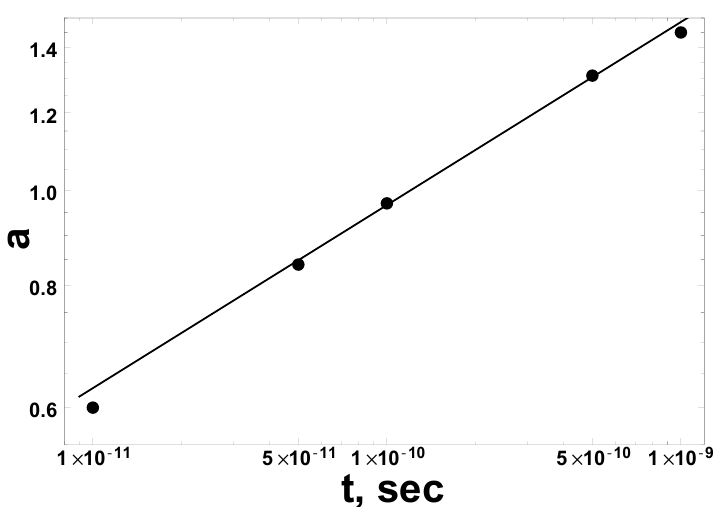
Figure 5. The time evolution of the spectral index of the power law distribution of photons below the peak, starting at the moment when it is first